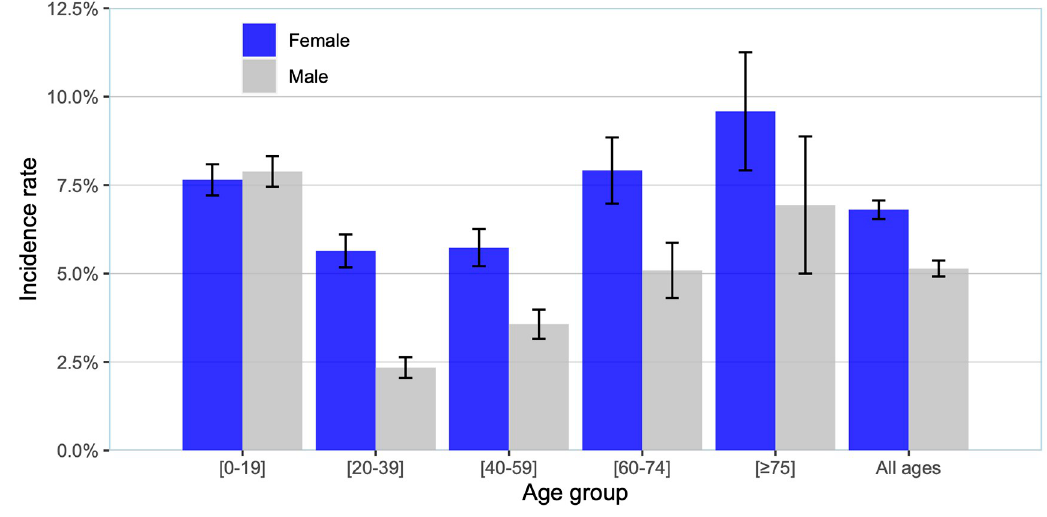
Fig 1. Scabies incidence rate per 1,000 habitants by sex and age group. The histograms represent the average scabies incidence rate in females (blue) and males (grey) according to age group.